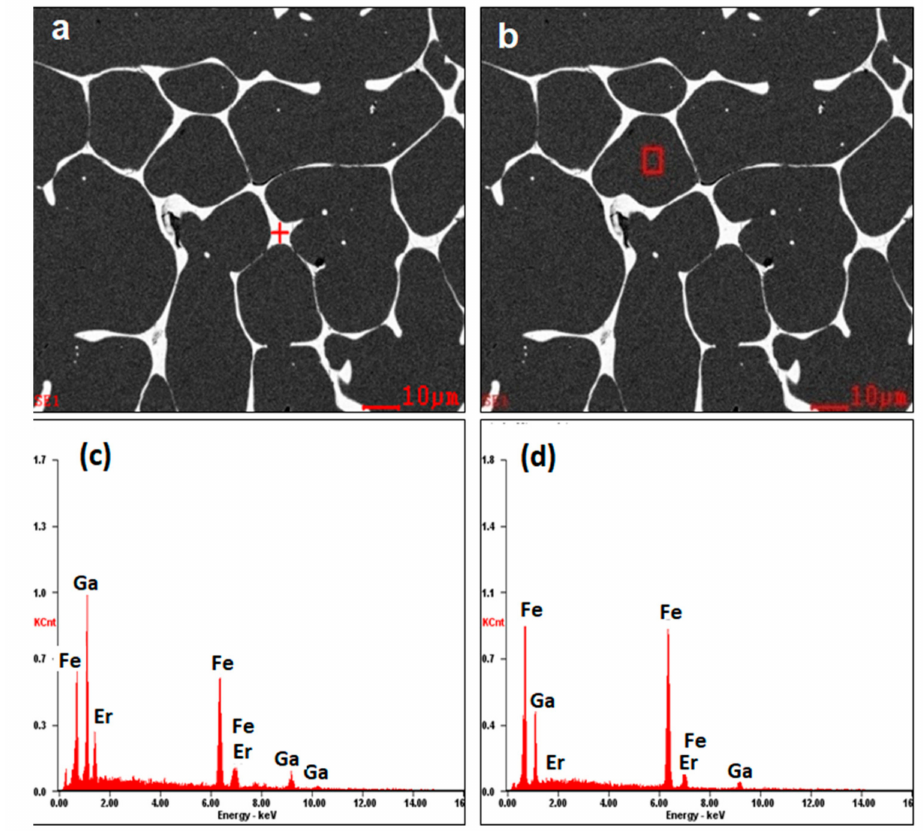
Figure 3. ( a , b ) SEM morphology of a sample of composition, Fe 83 Ga 17 Er 0.6 .; ( c , d ) EDXS profile of Fe, Ga and Er in the grain boundary region marked as “+” and in the intragranular region marked as “ (cid:3)